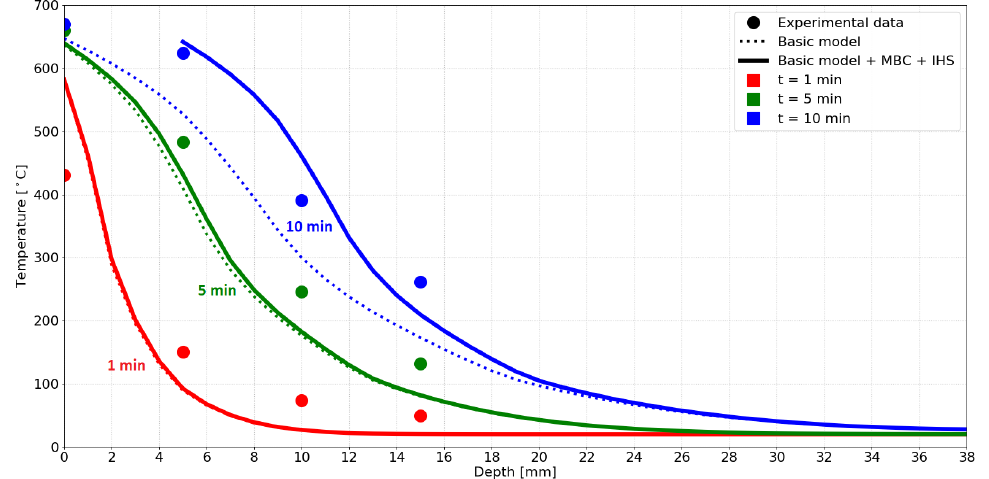
Figure 9. Simulation results compared with experimental data by Kashiwagi et al. [22].